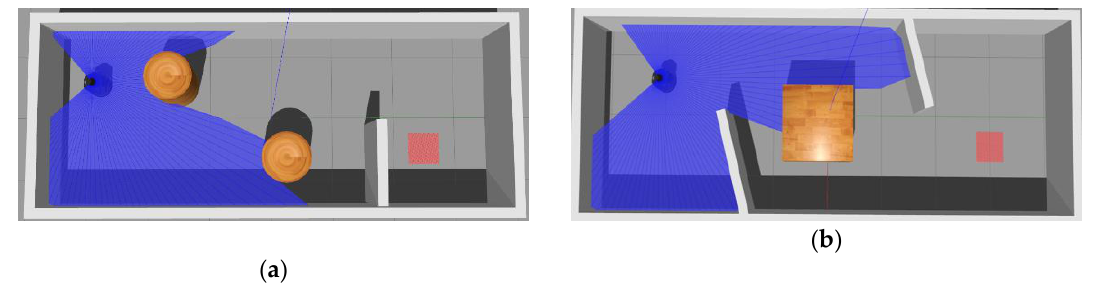
Figure 12. Changed four maps: ( a ) GT-MAP 1 and ( b ) GT-MAP 2.